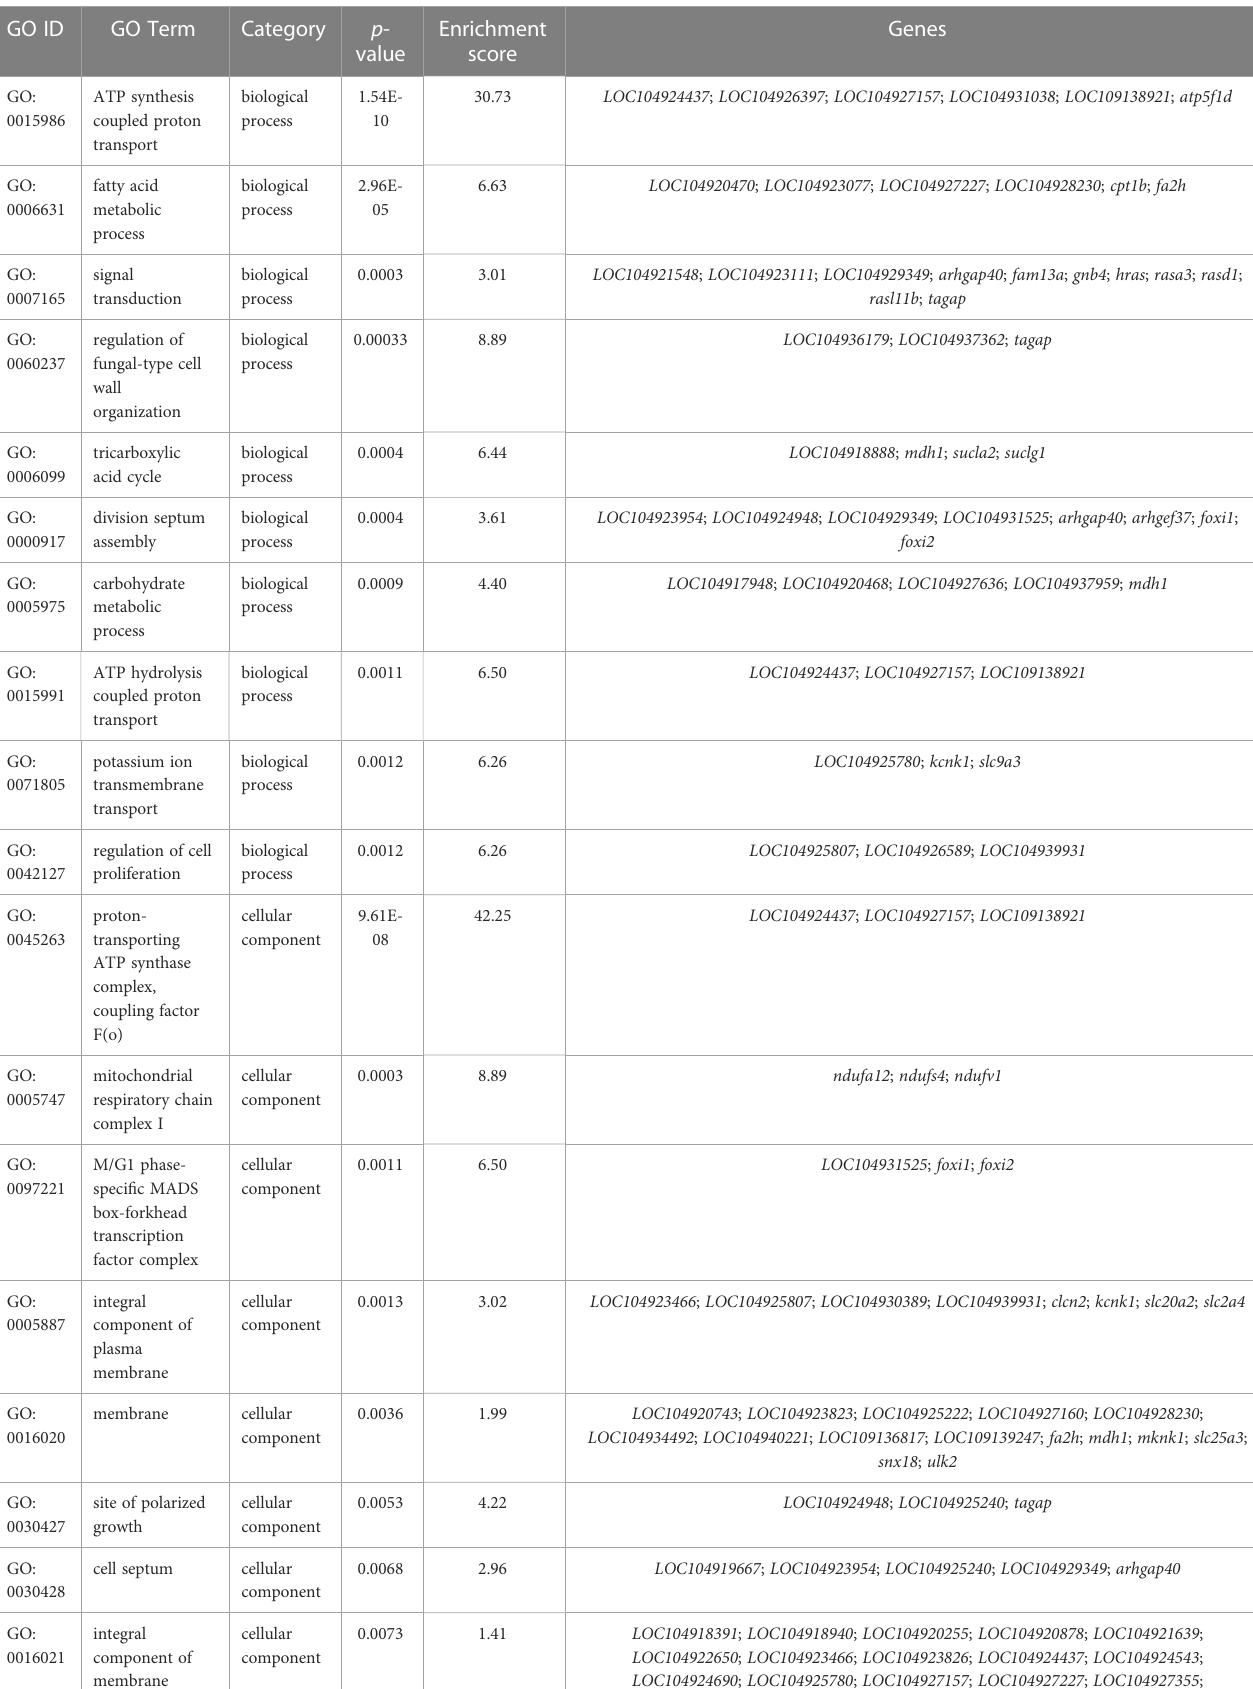
TABLE 6 GO analysis of the overlapped DMRs target DMGs in gills of large yellow croaker under low-salinity